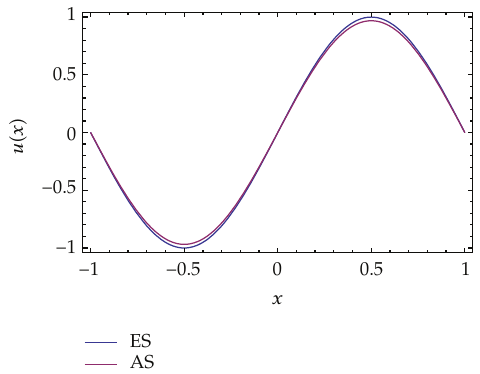
Figure 1: The compared results of the analytical and numerical solutions of Example 4.1 for t (cid:3) 0 . 5.